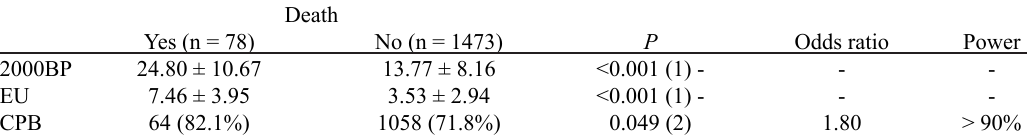
1. Descriptive level of probability of Student's t test 2. Descriptive level of probability of the chi-square